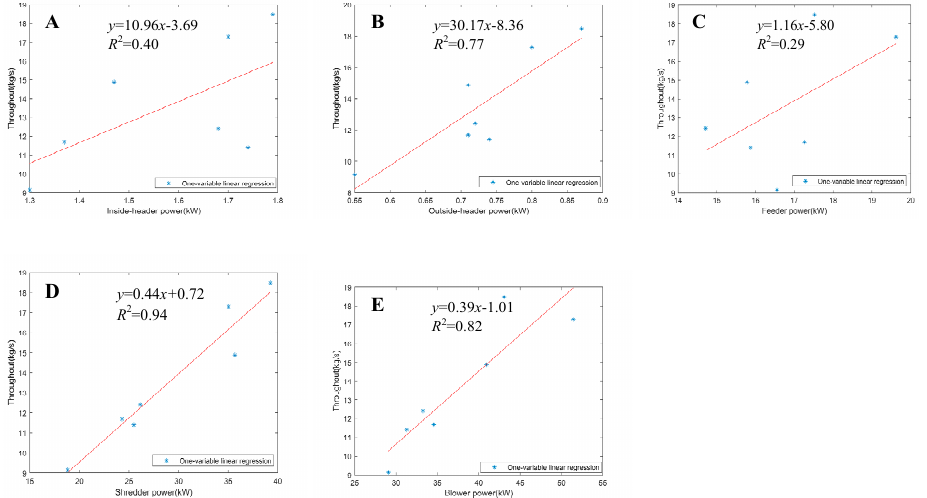
Figure 8. Results of the single-variable regression model; ( A ) The model between inside-header power and feeding rate; ( B ) The model between outside-header power and feeding rate; ( C ) The model between feeding power and feeding rate; ( D ) The model between shredding power and feeding rate; ( E ) The model between blowing power and feeding